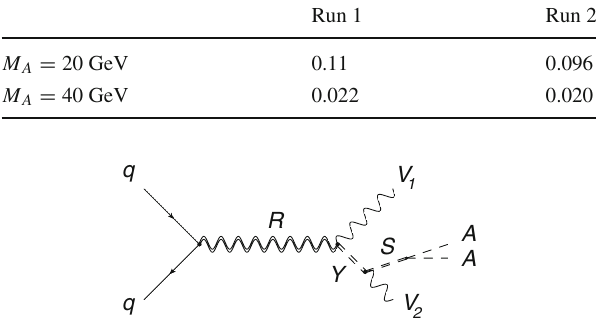
Table 2 Efficiencies of R → V S signals for the W Z selection in ATLAS hadronic diboson searches